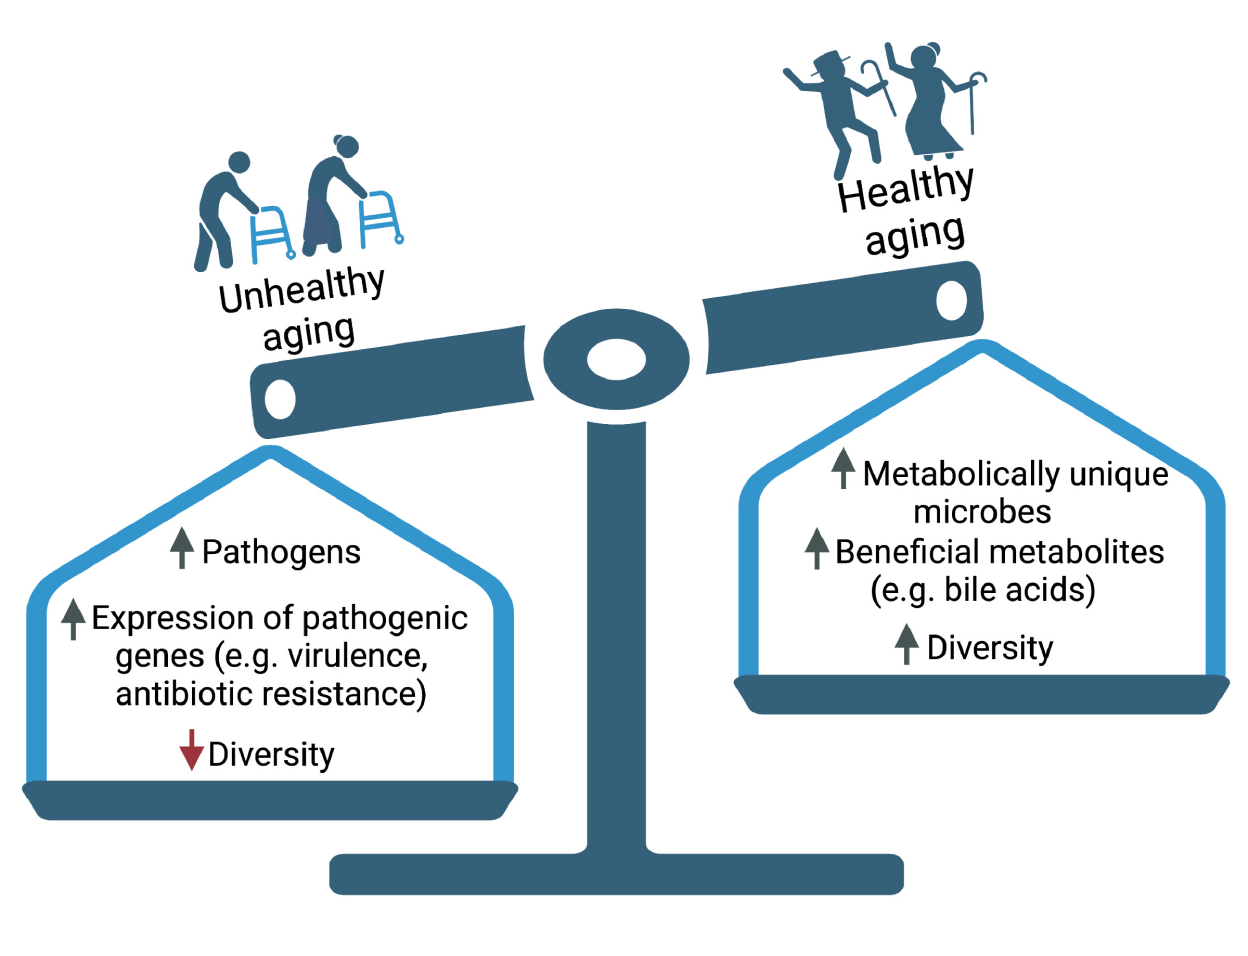
Fig 1. Lessons from the extremes of aging: Healthy centenarians and frail elderly. Aging can be considered as opposite sides of a balance tugged by the weights of various microbial factors, discussed in detail in this Essay. Created with BioRender.com.